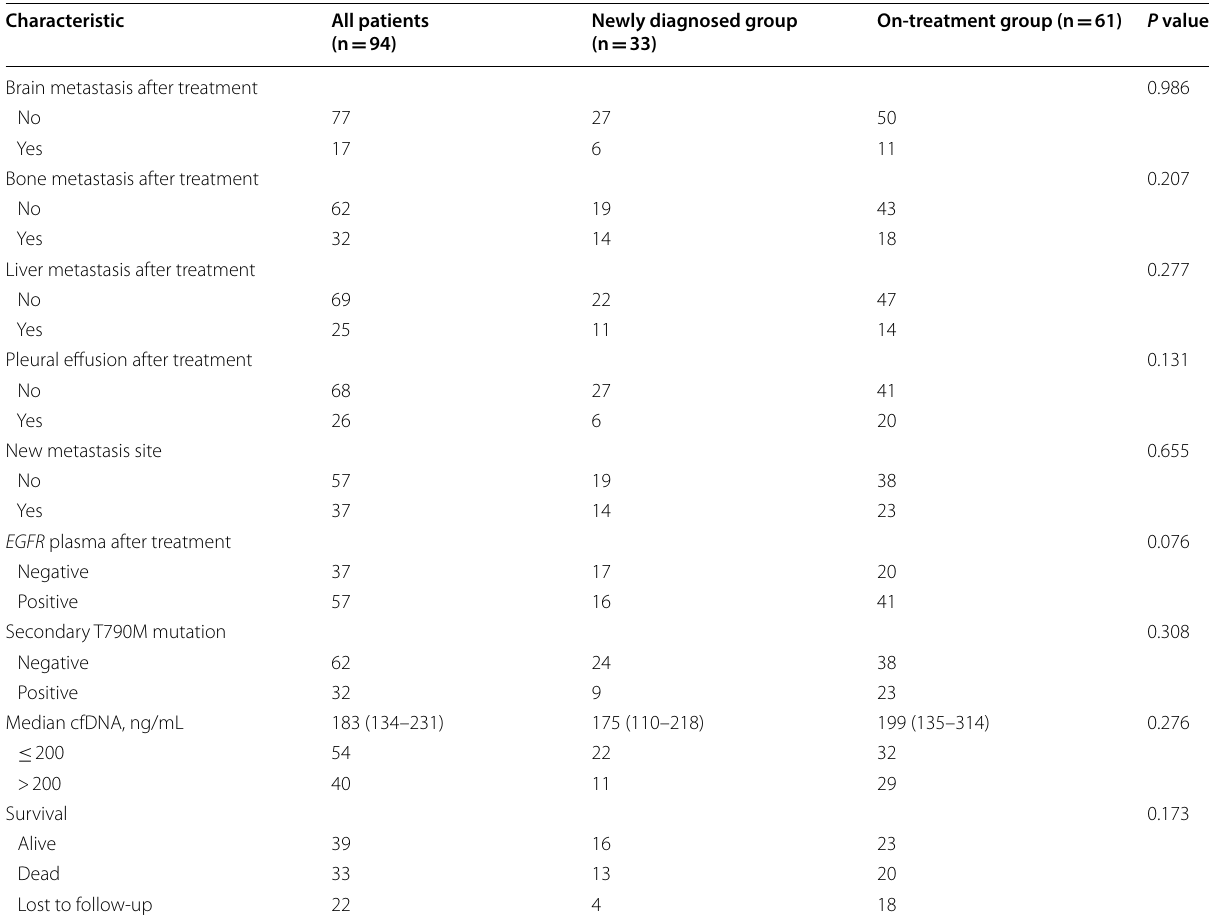
other characteristics were observed (Table 2). Multivariate analysis has shown that EGFR muta- tion status in post-treatment plasma with brain and new metastasis at post-treatment are three independ- ent predictive factors for resistance ( P and 0.028, respectively) (Table 3). Whereas, data of the newly diagnosed patients showed that only EGFR plasma test was identified as the independent factor, HR